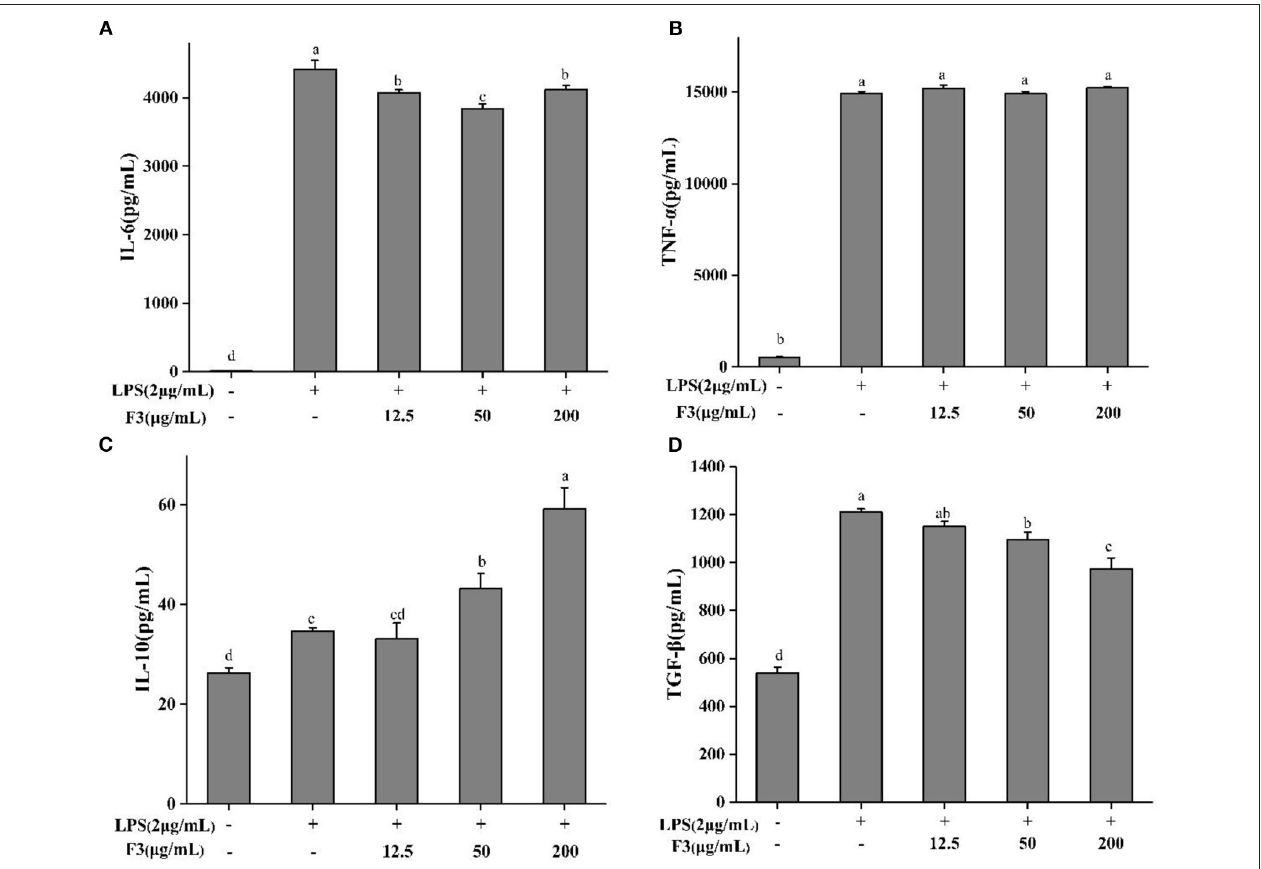
FIGURE 5 | The cytokines IL-6 (A) , TNE- α (B) , IL-10 (C) , and TGF- β (D) of pretreatment with F3 in RAW264.7 macrophage. The results were expressed as means ± SD ( n = 3), where lowercase letters indicate significantly different at p <